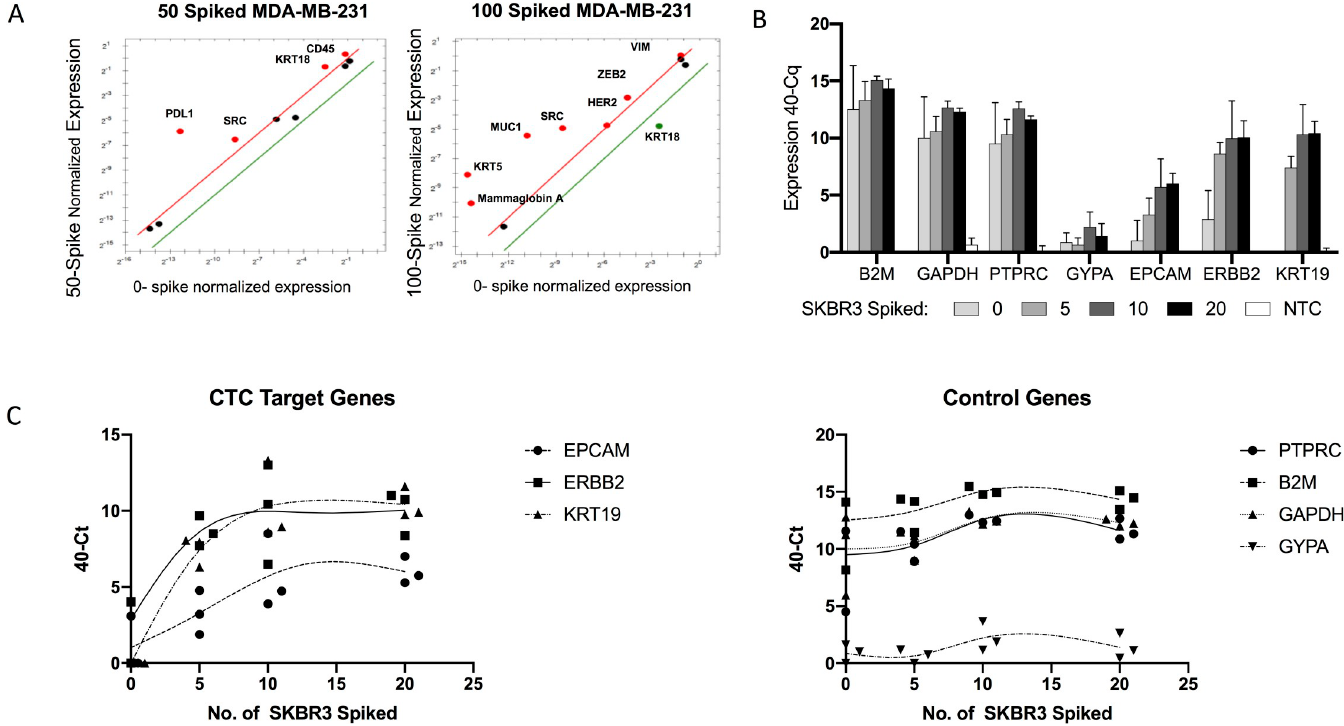
Fig 3. Gene expression by qRT-PCR after Parsortix PR1 enrichment. A) Using pre-amplification, qRT-PCR can detect MDA-MB-231–related genes in an enriched sample of 50 cells spiked into ~5 ml HDB. B,C) A panel of 9 genes was tested on independent spiked samples over a 2-week period using a smaller gene panel with no pre-amplification. Healthy donor blood was spiked with 0, 5, 10, or 20 SKBR3 cells prior to enrichment with Parsortix PR1 system.